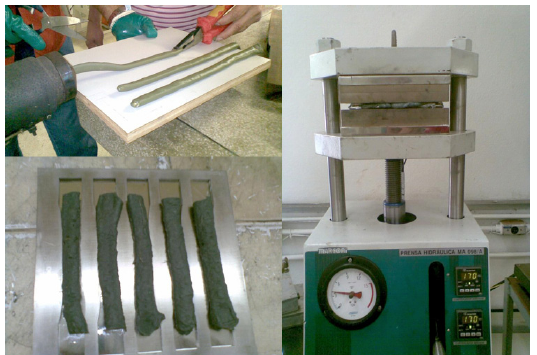
Figure 1. Tensile specimens manufacturing process. Figure 2. Tensile test set-up using